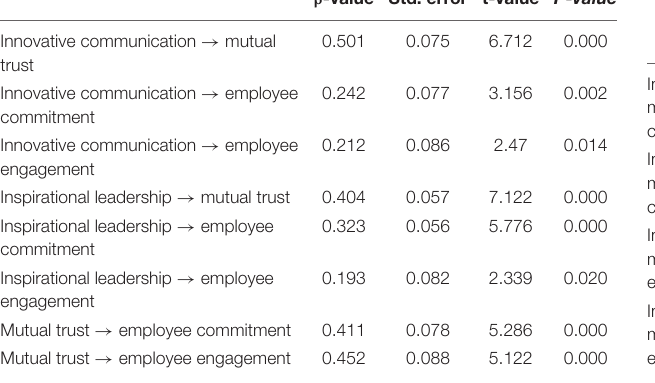
TABLE 5 | Indirect effects using